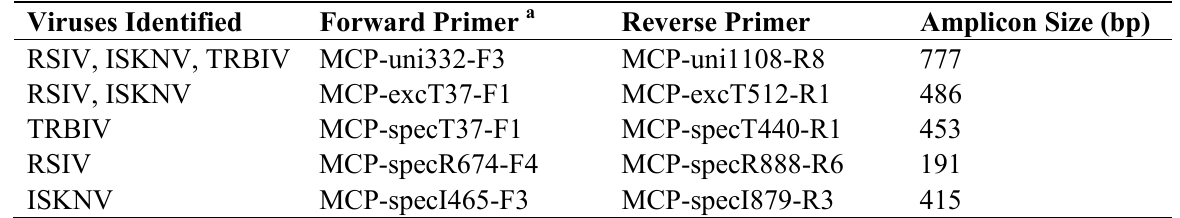
Table 1. Primer pairs for universal and selective amplification of megalocytivirus isolates. Viruses